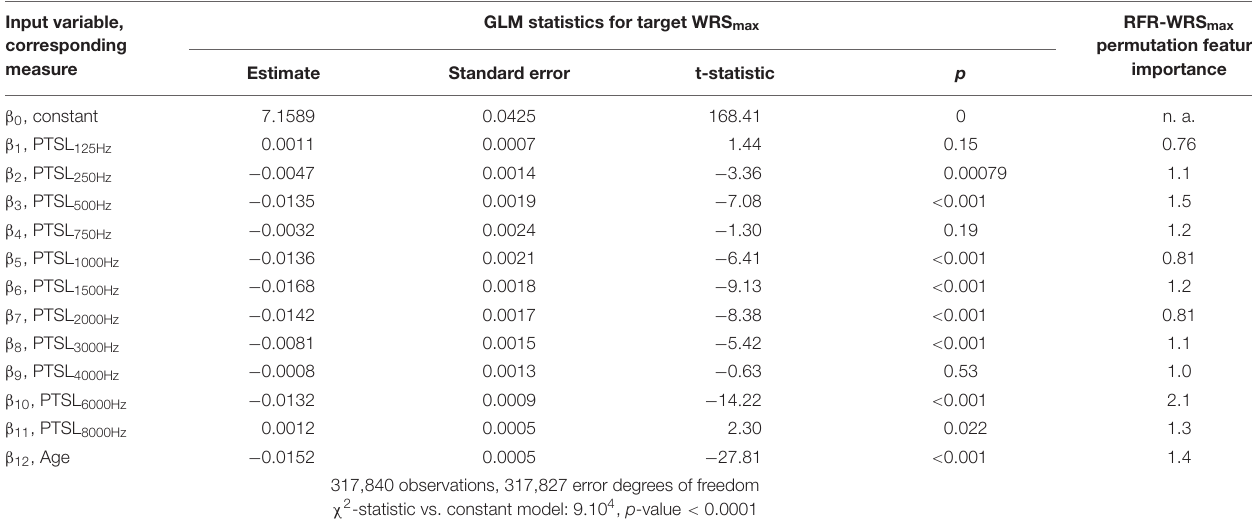
TABLE 2 | GLM parameters for target variable WRS max